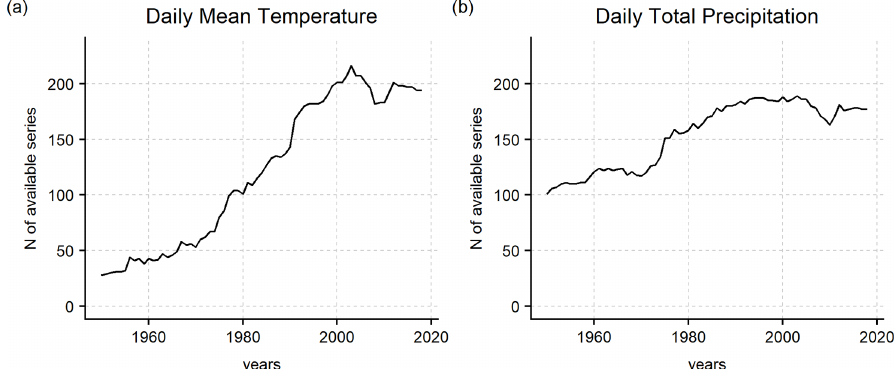
Figure 4. Number of available stations over the 1950–2018 period in the collected databases of (a) temperature and (b) precipitation.